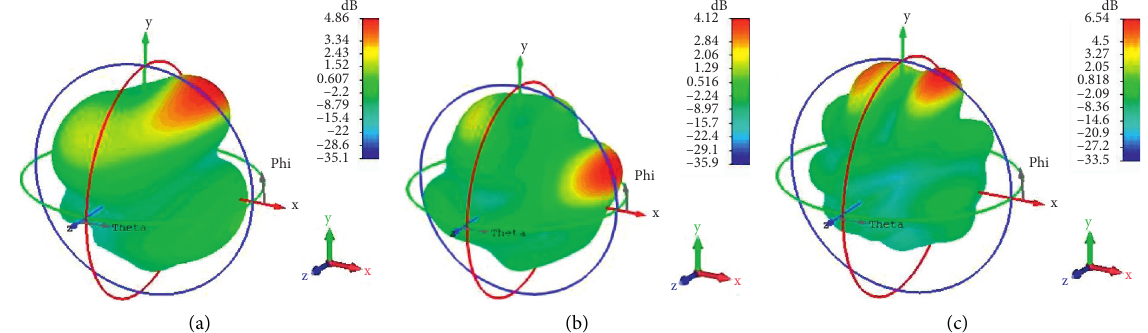
Figure 2: Free space return